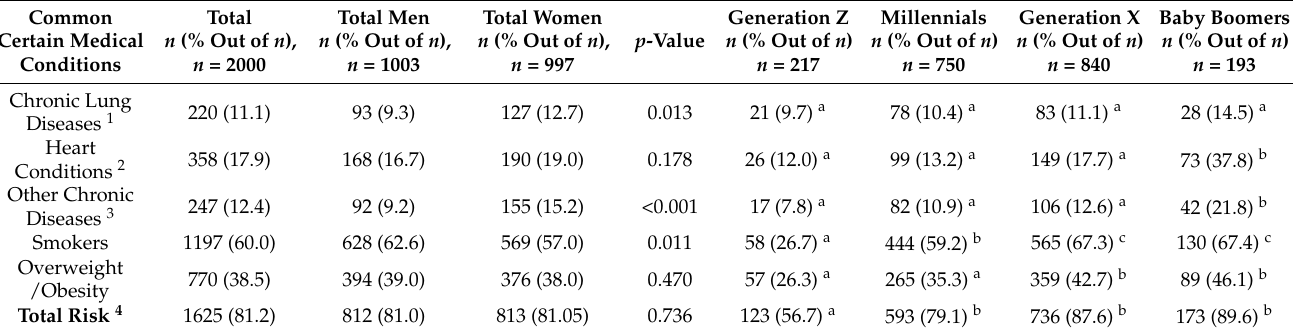
Table 2. Descriptive statistics for certain underlying medical conditions for a possible severe illness from COVID-19, among genders and generations in Volos, n =